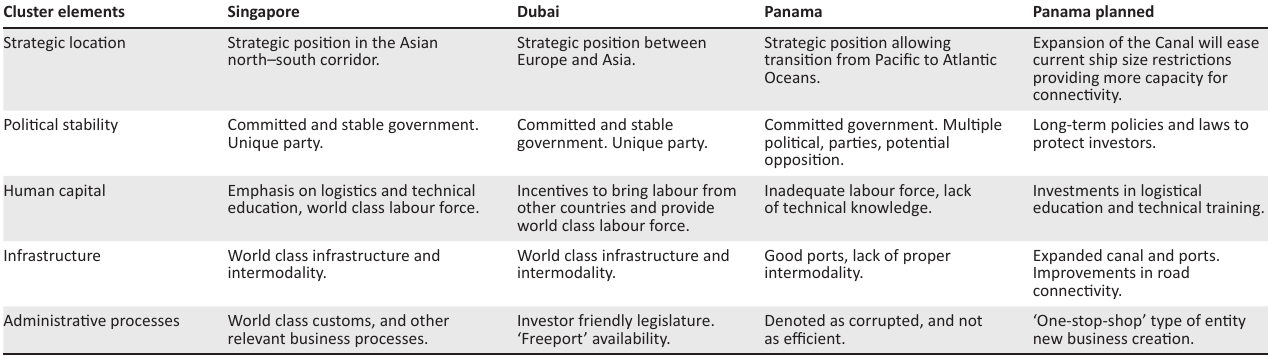
TABLE 1: Key elements of clusters. Cluster